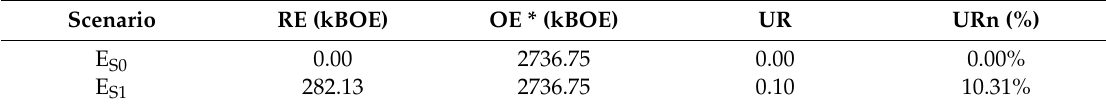
Table 16. The use of renewable energies (Res) in the energy supply.